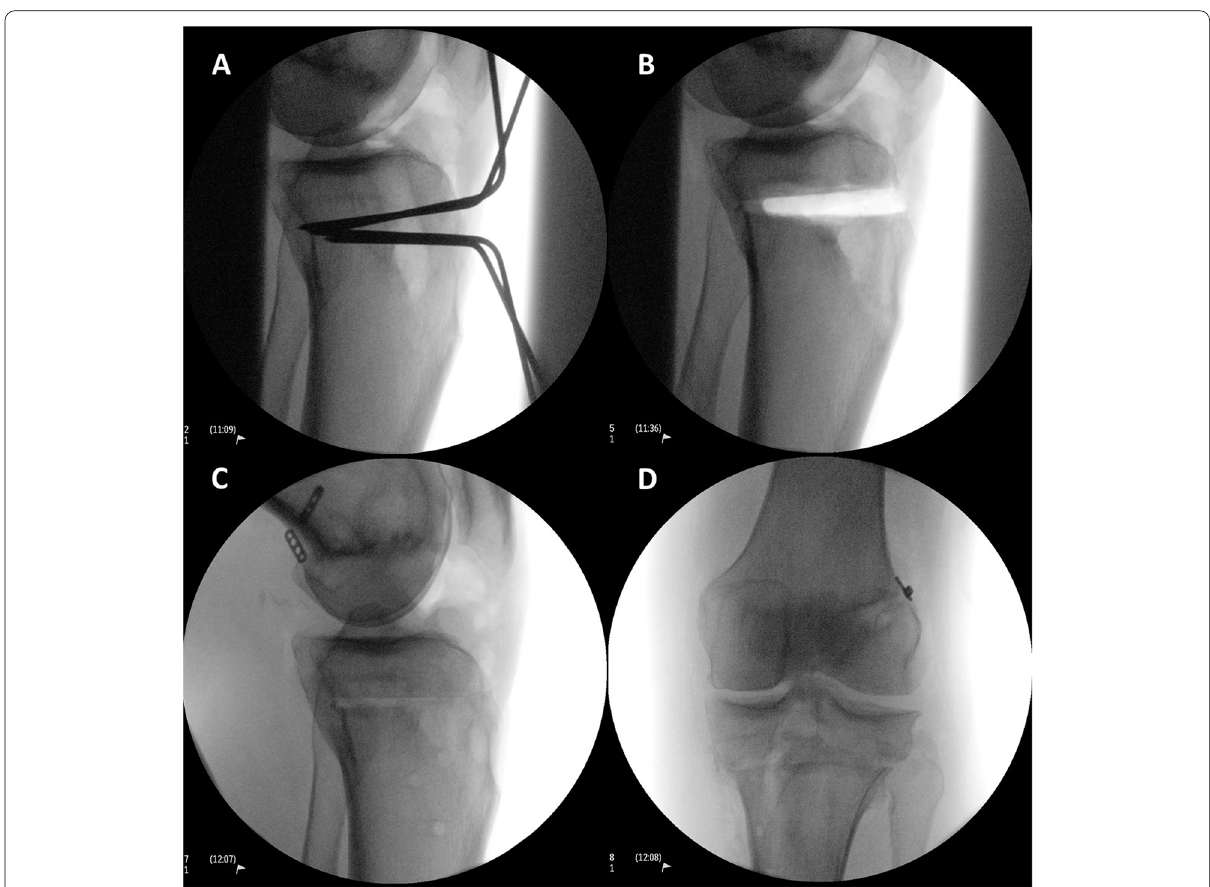
Fig. 1 Intra-operative fluoroscopy demonstrating an anterior closing wedge PTO. Guide pins are placed ( A ). The wedge of bone is removed leaving intact the posterior cortex ( B ). The osteotomy is compressed anteriorly and fixated ( C ). Coronal alignment is unchanged ( D